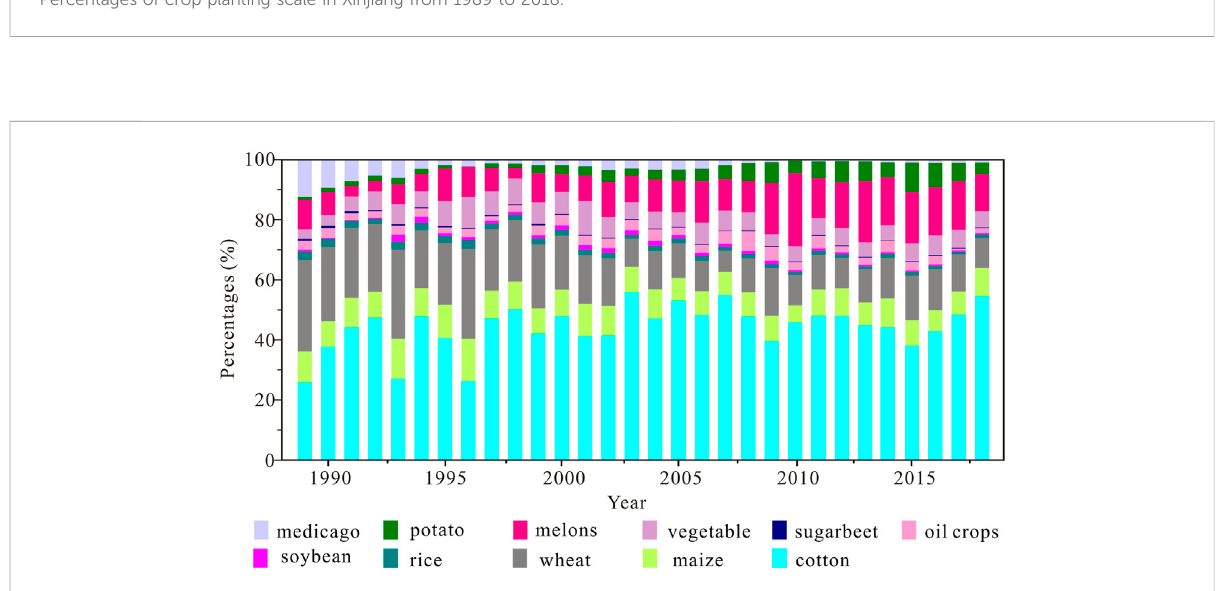
FIGURE 6 Percentages of crop output in Xinjiang from 1989 to